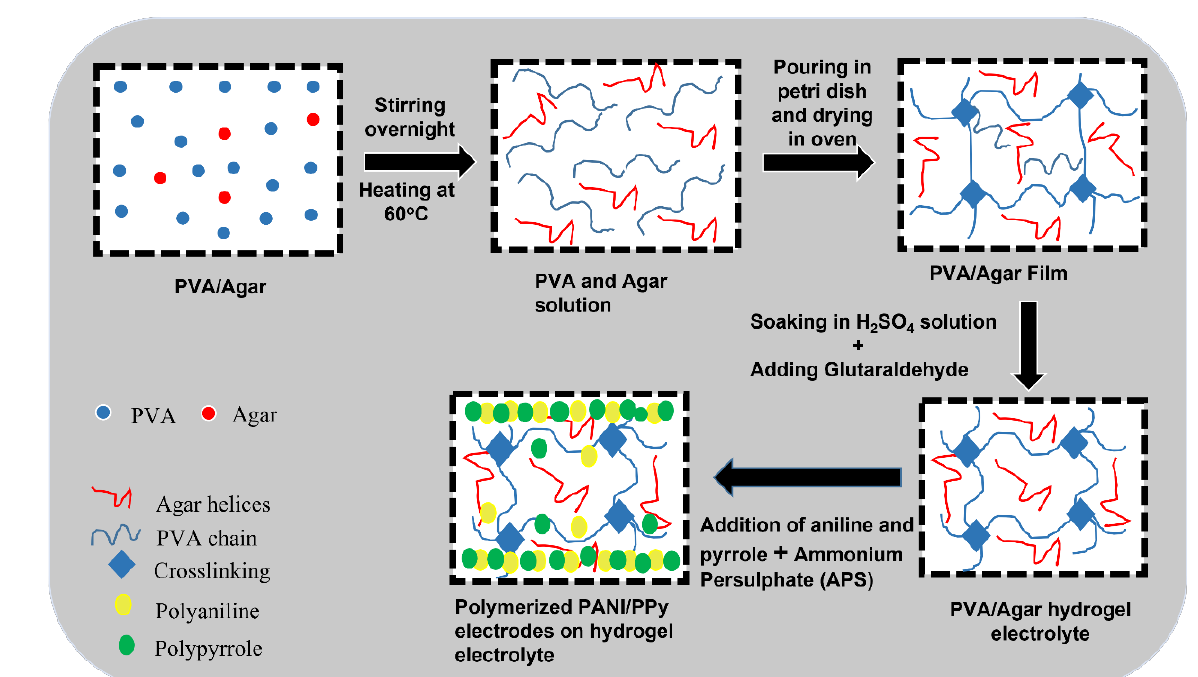
Figure 1. Illustration of the formation of electrolytes and electrodes. Table 1. Composition of all